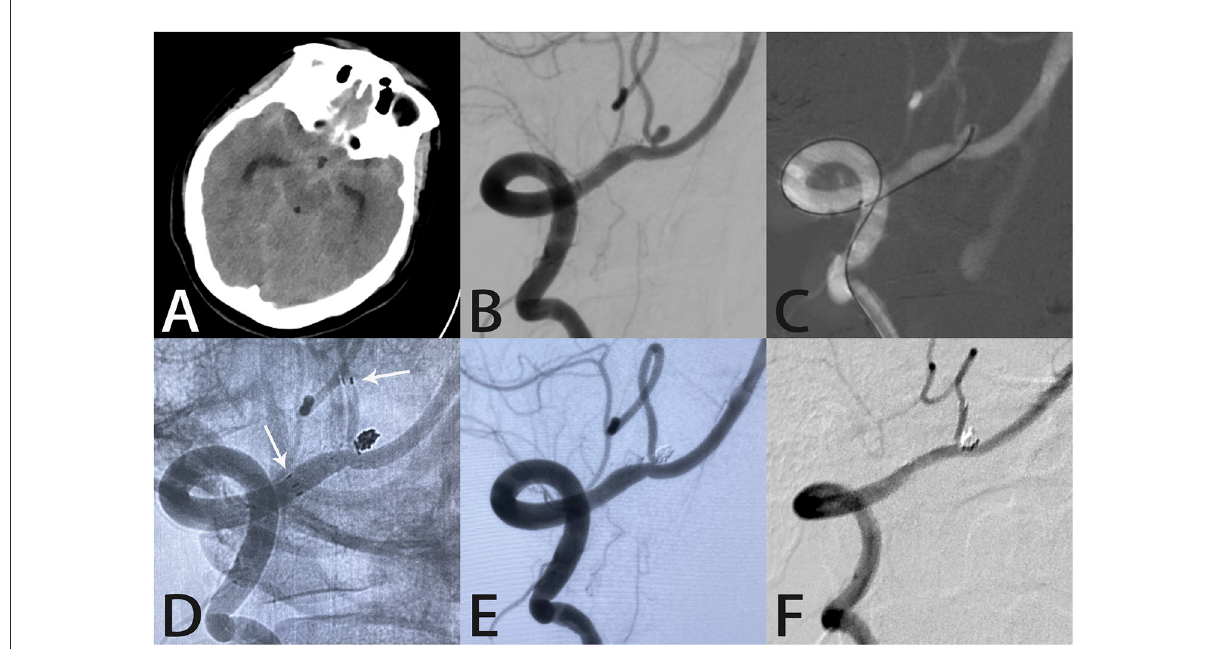
FIGURE2 Images from a 45-year-old woman with a tiny ruptured right posterior inferior cerebellar artery aneurysm. Computed tomography showed subarachnoid hemorrhage in the lateral fissure and basal cisterns (A) . Angiography demonstrated a right posterior inferior cerebellar artery aneurysm (B) . A microcatheter was delivered into the aneurysm sac (C) . An unsubtracted image showed the distal end of the Atlas stent (3.0 × 15mm) was placed in the right posterior inferior cerebellar artery with the proximal end in the right vertebral artery (white arrows indicate the ends of the stent) (D) . Angiography immediately after the procedure showed complete aneurysm occlusion and unobstructed blood flow in the posterior inferior cerebellar artery (E) . Follow-up angiography 7 months later showed complete aneurysm occlusion with the coils densely packed within the aneurysm sac (F)